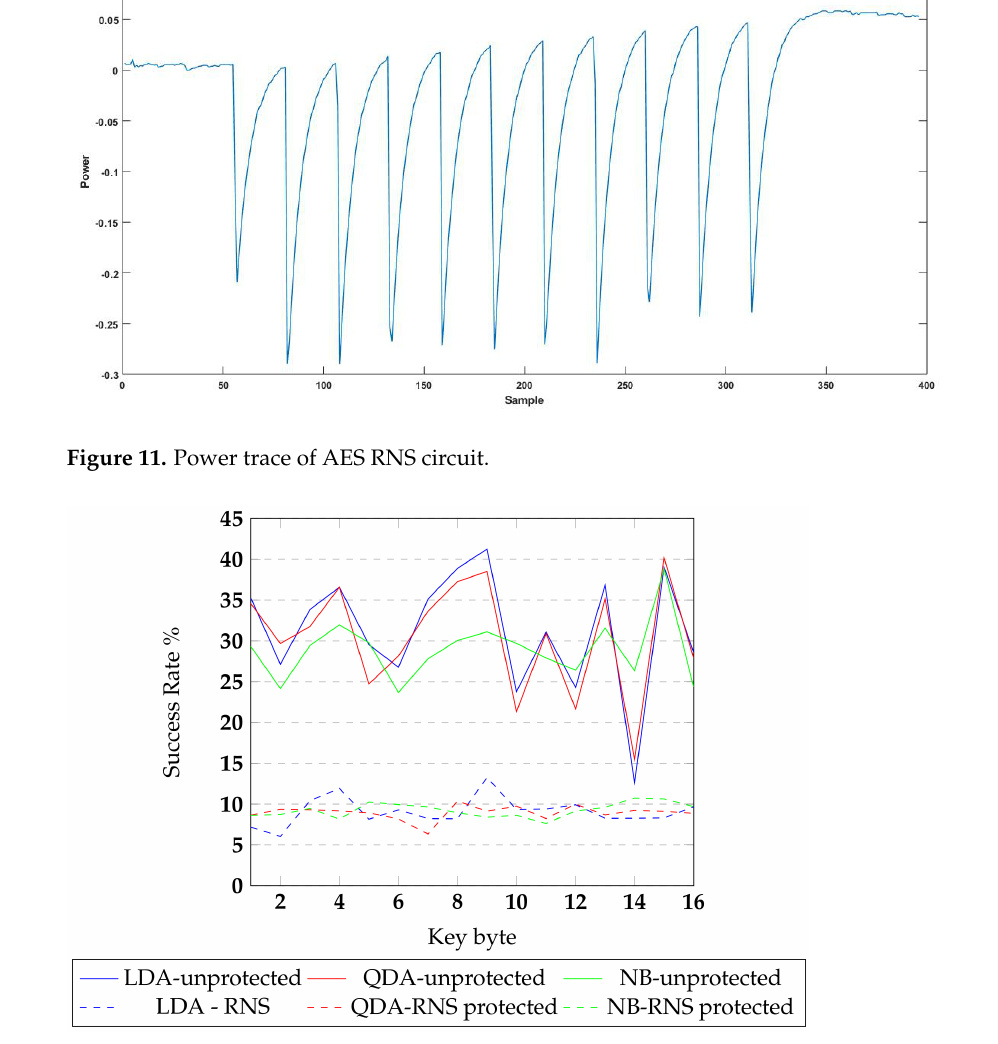
Figure 12. Classifier results on secure